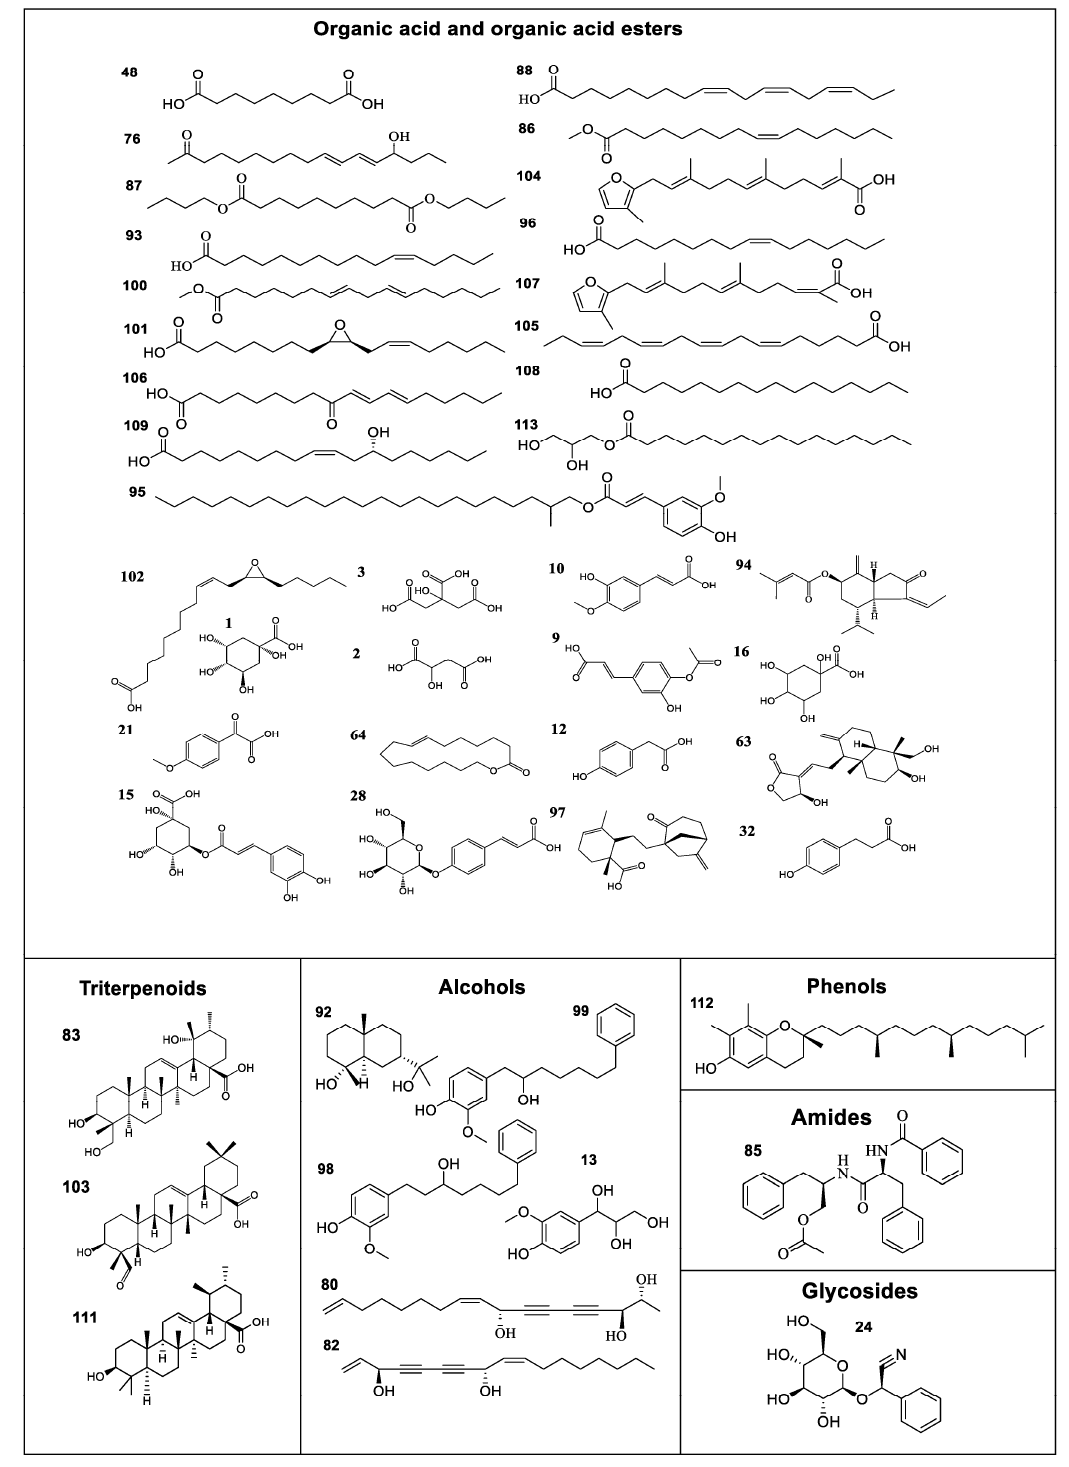
Figure 2. Chemical structures of compounds identified in HD and HC.